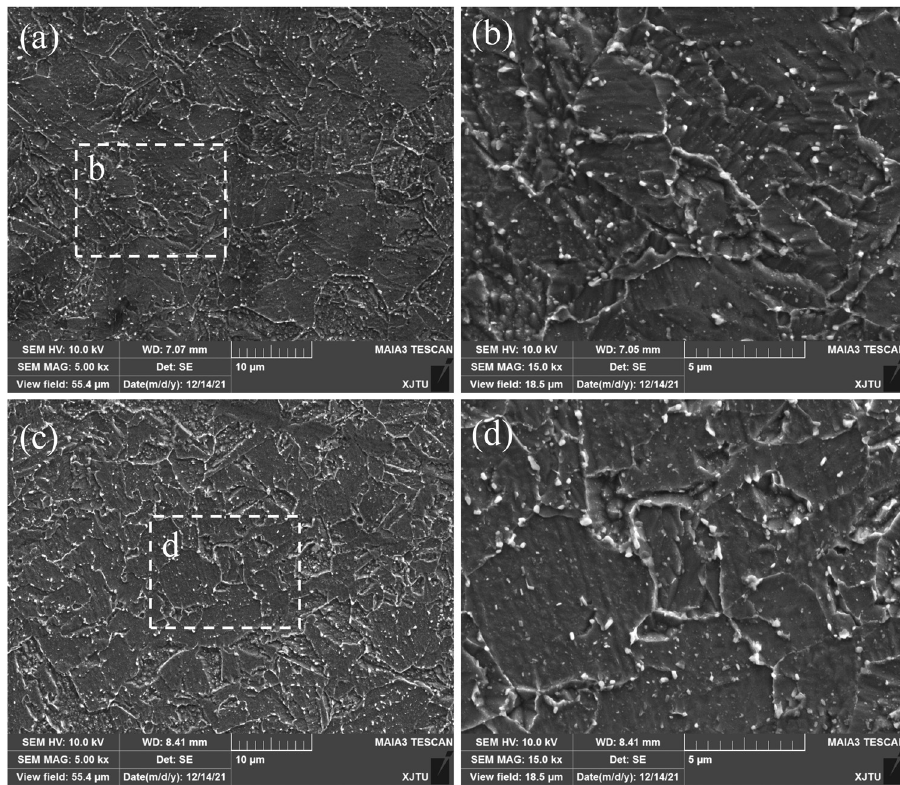
Figure 4: SEM images showing microstructures of the 2.25Cr1Mo0.25V steel: ( a and b ) BM and ( c and d )